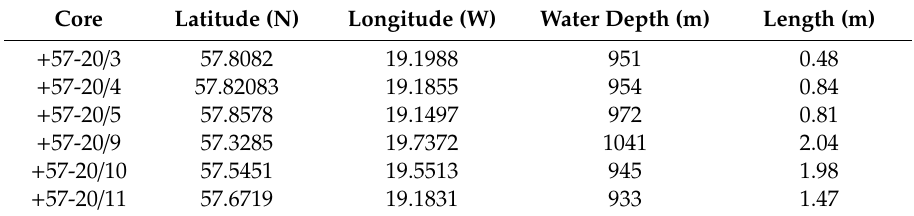
Table 1. Gravity cores studied in this work and collected from Hatton Bank. Latitude and longitude are taken from the BGS O ff shore GeoIndex (https: // www.bgs.ac.uk / GeoIndex / o ff shore.htm). Core Latitude (N) Longitude (W) Water Depth (m) Length (m) + 57-20 / 3 57.8082